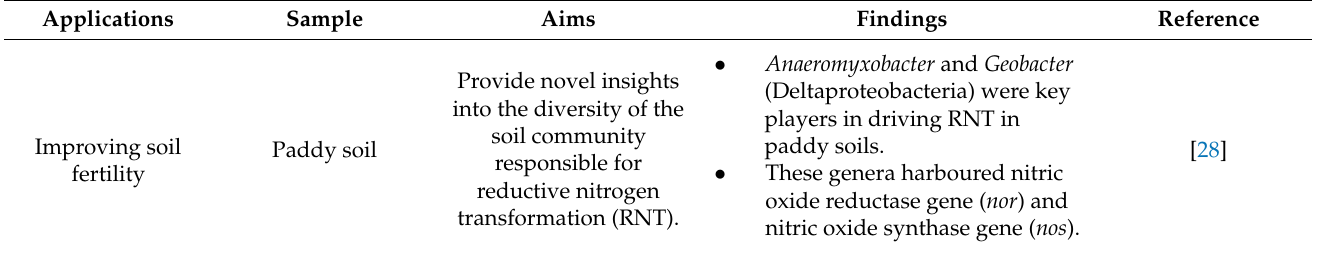
Table 1. The applications of metatranscriptomics in elucidating the functional role of the microbiome to increase crop productivity, which contributes to SDGs 2, 11, and